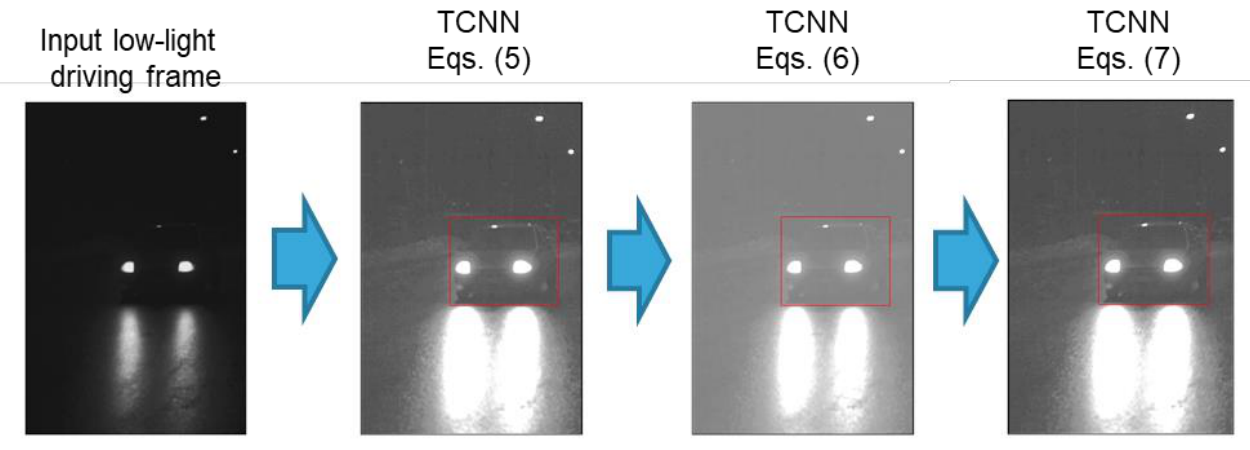
Figure 2. An instance of the low-light image enhancement performed by the proposed TCNN. As shown in Figure 2, the TCNN-based framework is able to significantly improve the light exposure of the source image representative of the driving scenario. The output image which is represented by the image processed by the cloning templates setup reported in Equation (7), represents the frame on which the downstream intelligent segmentation deep architecture will be